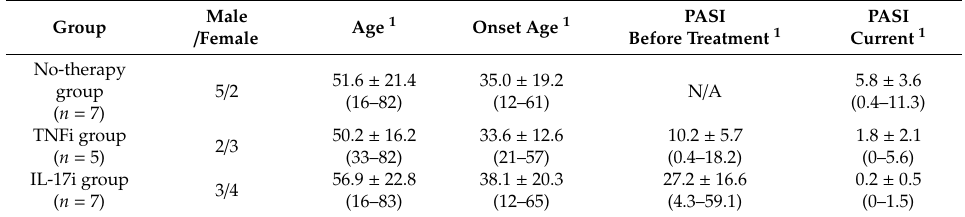
Table 1. Patient characteristics.